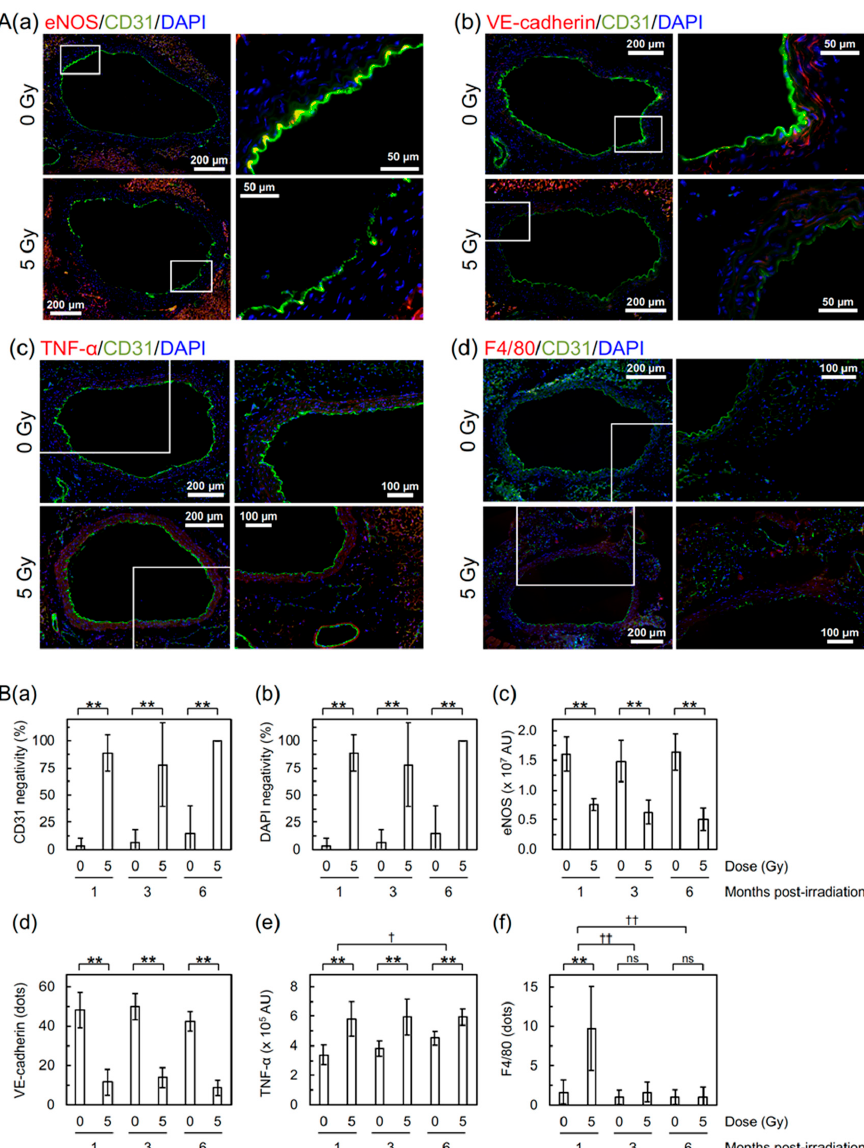
Figure 3. Molecular changes in the aortic endothelium of B6J mice. ( A ) Representative merged images for double immunofluorescence of CD31, and ( a ) eNOS, ( b ) VE-cadherin, ( c ) TNF- α , or ( d ) F4 / 80, with cell nuclei counterstained with DAPI. ( a , d ) 1 month post-irradiation. ( b , c ) 3 months post-irradiation. Upper panels, 0 Gy. Lower panels, 5 Gy. Boxed areas in the left panels (tiled images) are shown at higher magnification in the right panels. Scale bars as indicated. ( B ) Quantitative analysis for ( a ) CD31 negativity, ( b ) DAPI negativity, ( c ) eNOS, ( d ) VE-cadherin, ( e ) TNF- α , and ( f ) F4/80. For CD31 negativity, DAPI negativity and VE-cadherin, there was no difference among three post-irradiation timepoints in irradiated groups (ANOVA p > 0.06) and in sham-irradiated controls (ANOVA p > 0.1). A difference among three post-irradiation timepoints was significant for eNOS (ANOVA p = 0.02, pairwise p = 0.01 for 1 vs. 6 months) and F4/80 (ANOVA p = 2 × 10 − 6 , pairwise p < 2 × 10 − 5 for 1 vs. 3 months and 1 vs. 6 months) in irradiated groups but not in sham-irradiated controls (ANOVA p >